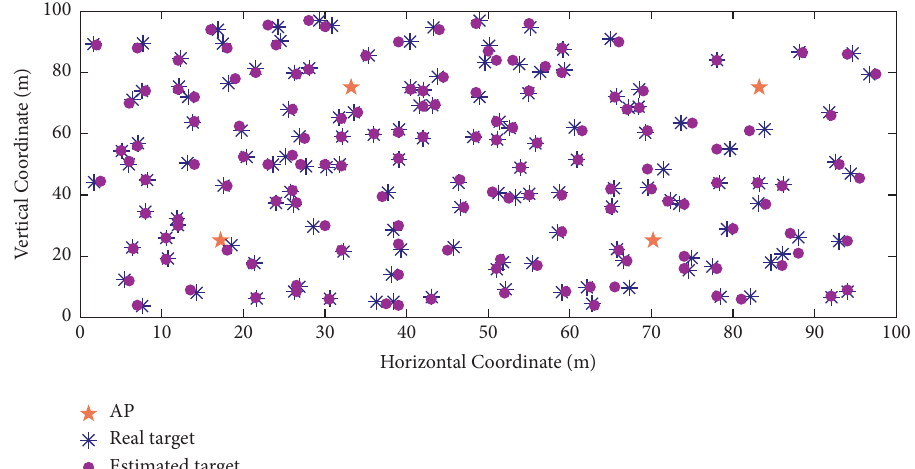
) with 2 m grid distance, 4 APs, and K � 4. 0